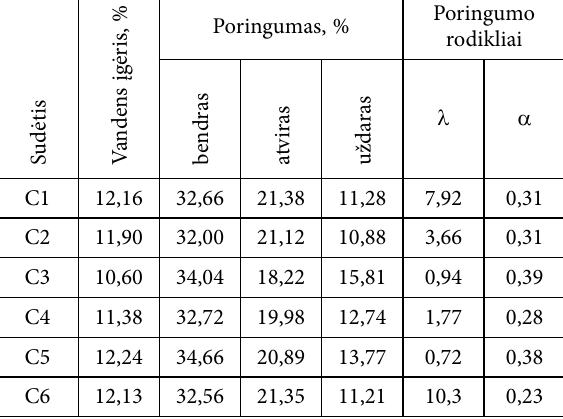
Table 4. Porosity parameters of hardened cement paste